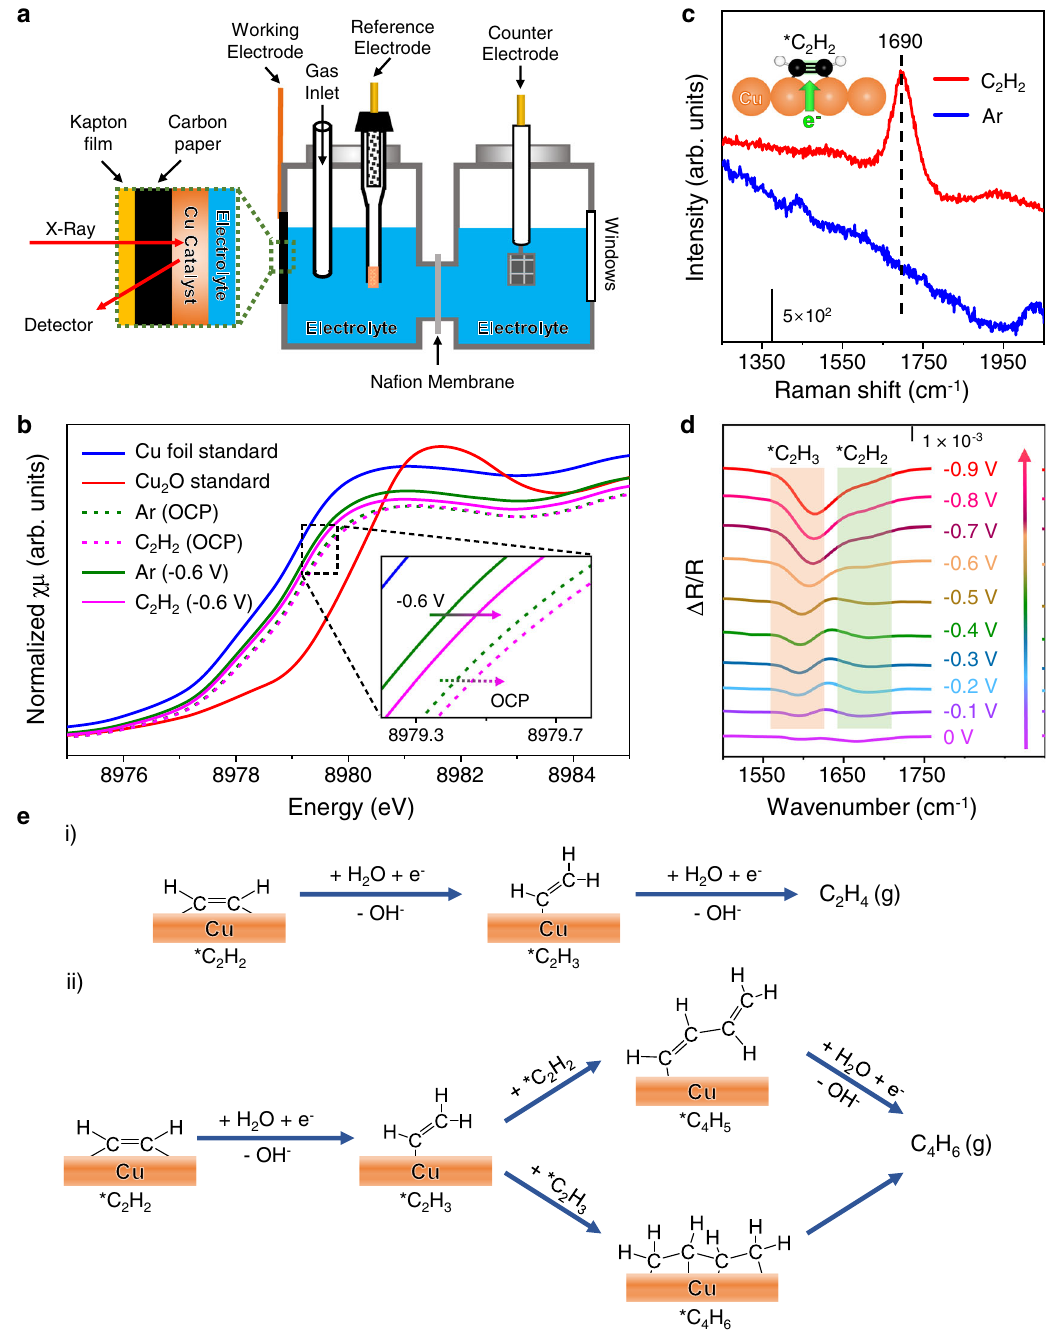
Fig. 3 In-situ spectroscopic characterizations of the Cu catalyst and the reaction intermediates. a The schematic illustration of in-situ XANES electrolytic cell. b The in-situ Cu K-edge XANES of the catalyst in Ar-saturated and C 2 H 2 -saturated solution at OCP and − 0.6 V, compared with those of Cu foil and Cu 2 O standard sample. c The in-situ Raman spectra of the catalyst in Ar-saturated solution and C 2 H 2 -saturated solution. d The in-situ ATR-FTIR spectra during the E-HAE process at potentials from 0 to − 0.9 V in C 2 H 2 -saturated solution. The re fl ection intensity is decreased due to infrared absorption of surface species; thus, the generation of species leads to a negative peak. e The proposed reaction routes for the formation of (i) ethylene and (ii) 1,3-butadiene. All the potentials in the fi gures are referenced to the RHE. The in-situ XANES and Raman experiments were conducted in 1 M KOH solution at 25 °C. The in-situ ATR-FTIR experiments were conducted in 0.1 M KOH solution at 25 °C. Source data are provided as a Source Data fi hydrogenation reaction mechanism was then investigated on the electron-coupled proton transfer from the water layer to the C 2 H 2 -covered surfaces. C 2 H 2 -covered surfaces also requires high barriers of approxi- The formation of surface H species ( * H) on the C 2 H 2 -covered mately 0.81, 1.84, and 0.97 eV on the Cu(100), (110), and (111) surfaces is energetically unfavorable with Δ G ads of 0.56, 0.17, and surfaces, respectively. These results demonstrate that * H can 0.49 eV on the Cu(100), (110), and (111) surfaces, respectively hardly be formed on the C 2 H 2 -covered Cu surfaces, which could explain the poor HER activity at potentials above − 0.6 V vs. RHE. (Fig. 4c). In addition, the formation process of * H via